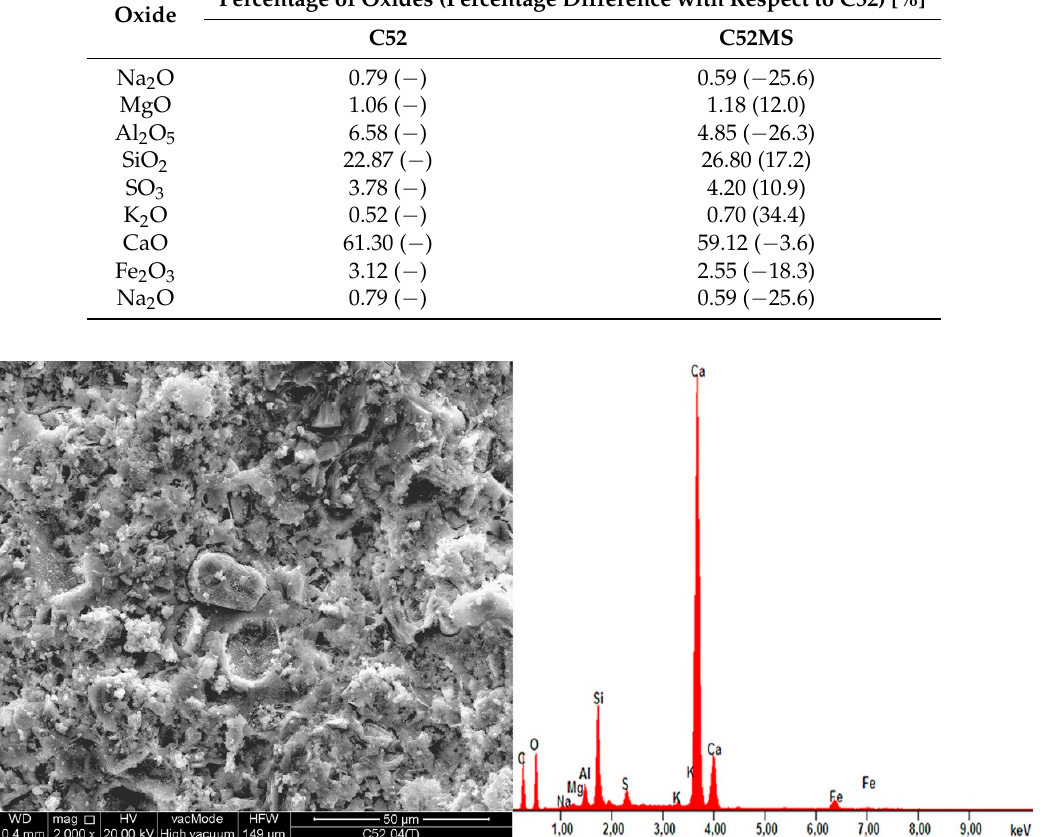
Figure 10. EDS spectra of the C52 sample together with the SEM image of the area analyzed.